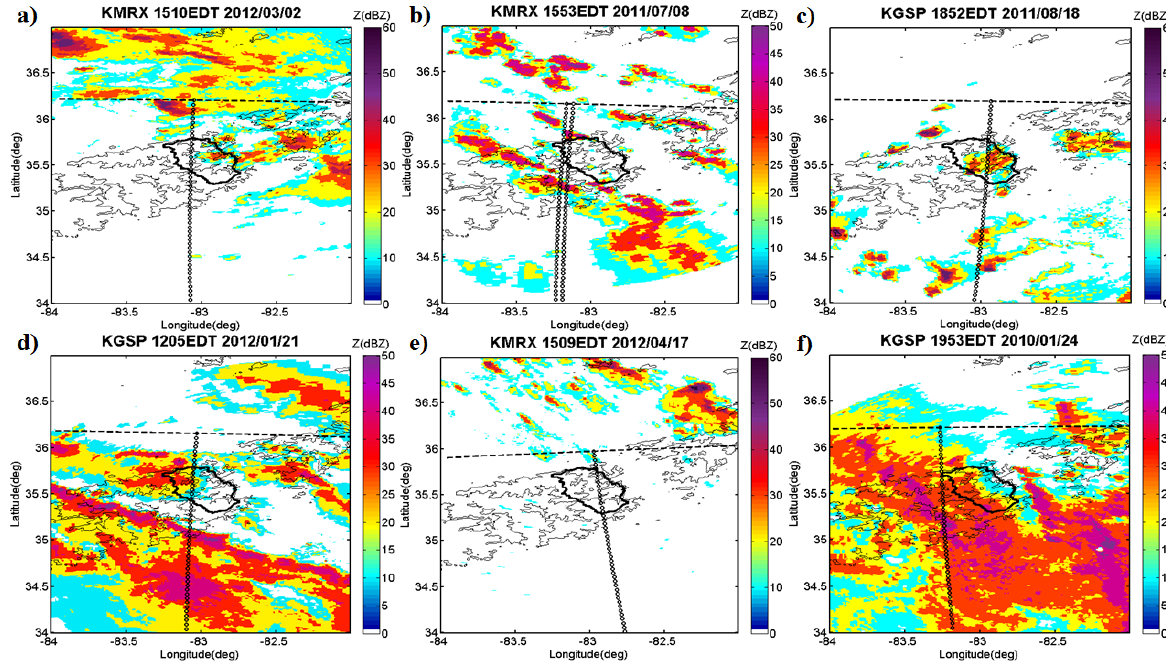
Figure 9. Base reflectivity composites from KMRX (Knoxville, TN) and KGSP (Greer, SC) National Weather Service radars corresponding to the overpass times shown in Figs. 10–12 below. The lines of black circles show the overpass tracks corresponding to the cross sections in Figs. 10–12. The dashed line delimits the northern boundary of the TRMM PR swath over the southern Appalachians, and the 1000m terrain elevation contour line and the outline of the study region (the Pigeon River basin) are marked in solid black for